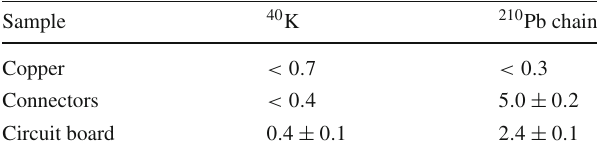
Table 2 Results of the screening